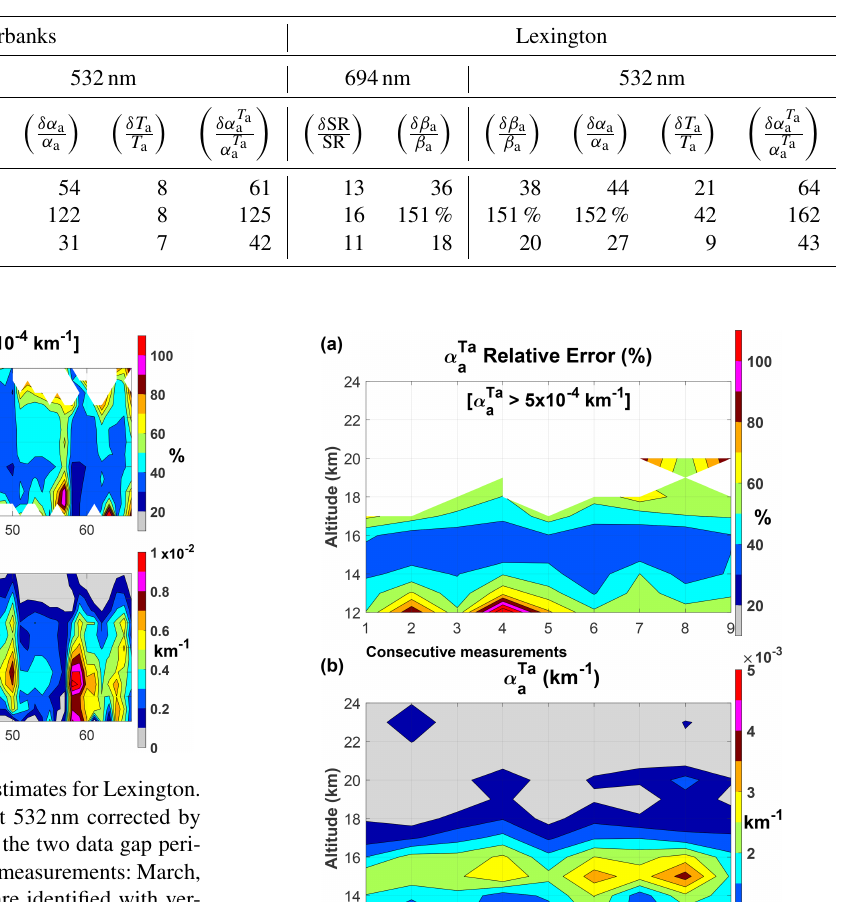
Table 4. Relative error estimates of the backscattering ratio, aerosol backscatter at 694nm and 532nm, and aerosol extinction with and without correction for aerosol two-way transmittance at 532nm for Lexington and Fairbanks. Errors for α T a a ≤ 5 × 10 − 4 km − 1 were not included in the statistics. All errors are percentages.